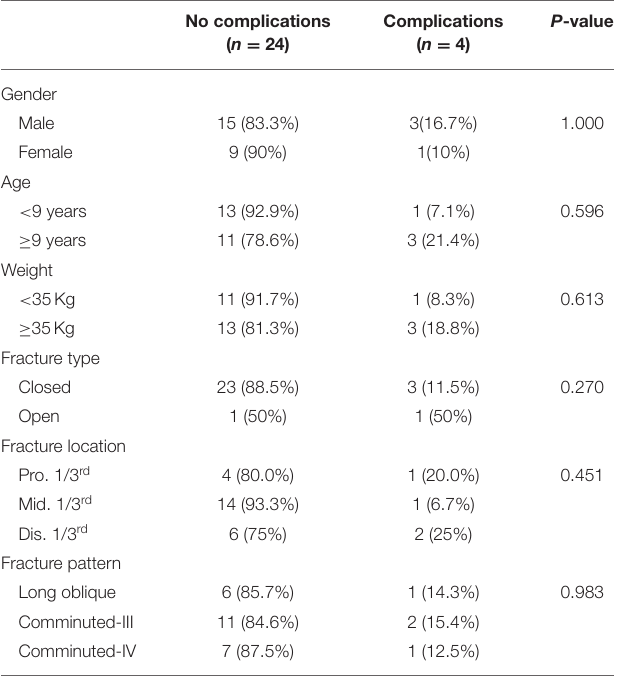
TABLE 5 | Complications according to gender, age, weight and fracture